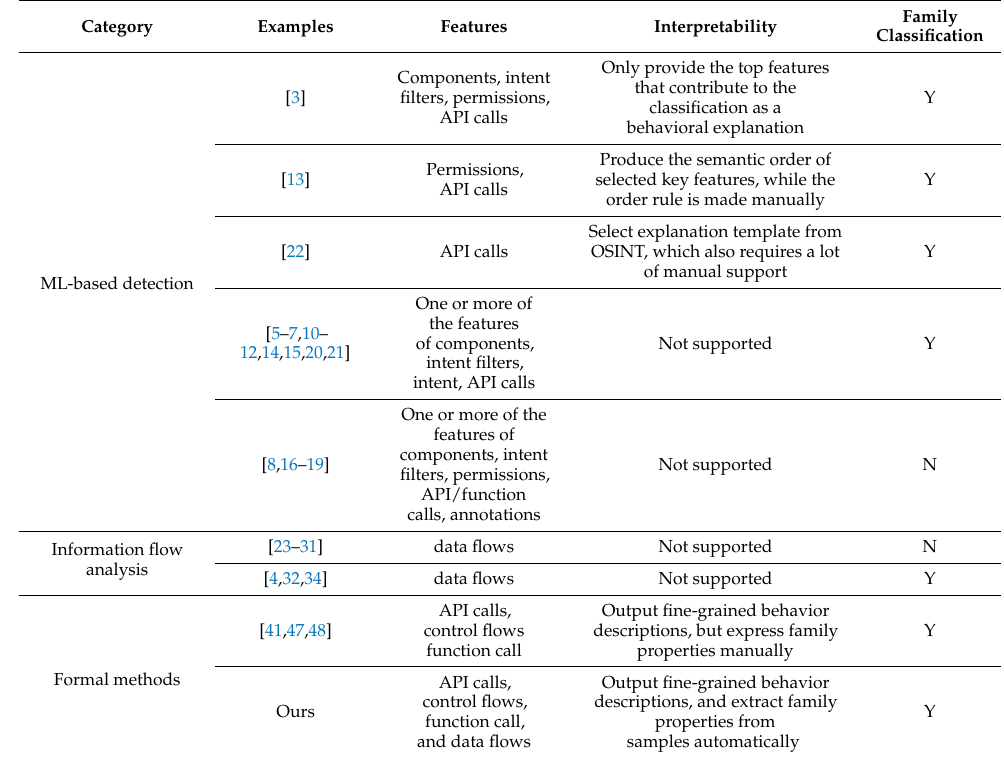
Table 1. Comparison with related